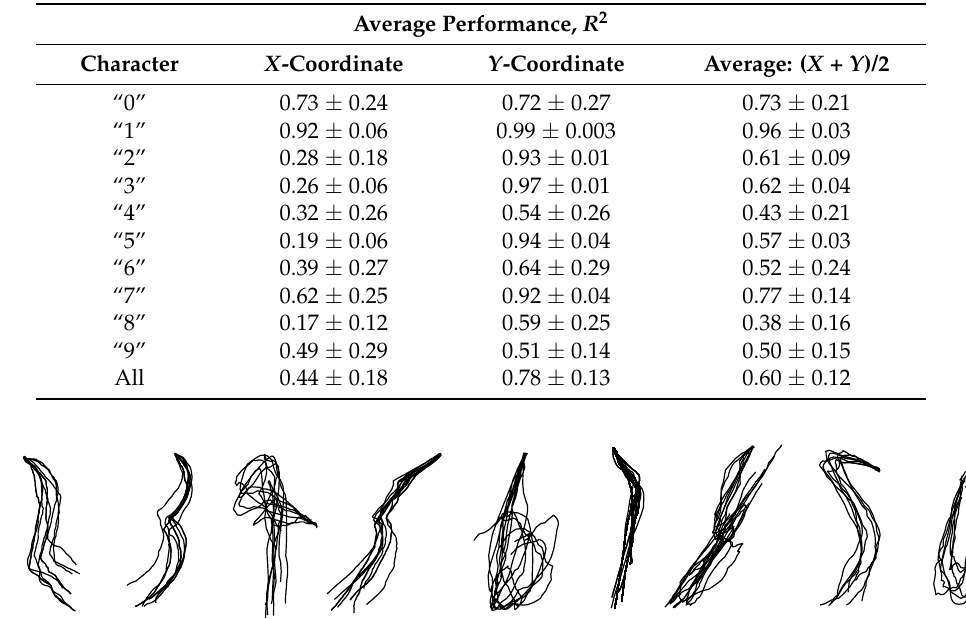
Figure 8. The randomly selected reconstructed numeric character of between-group reconstruction by the KF-GEP.